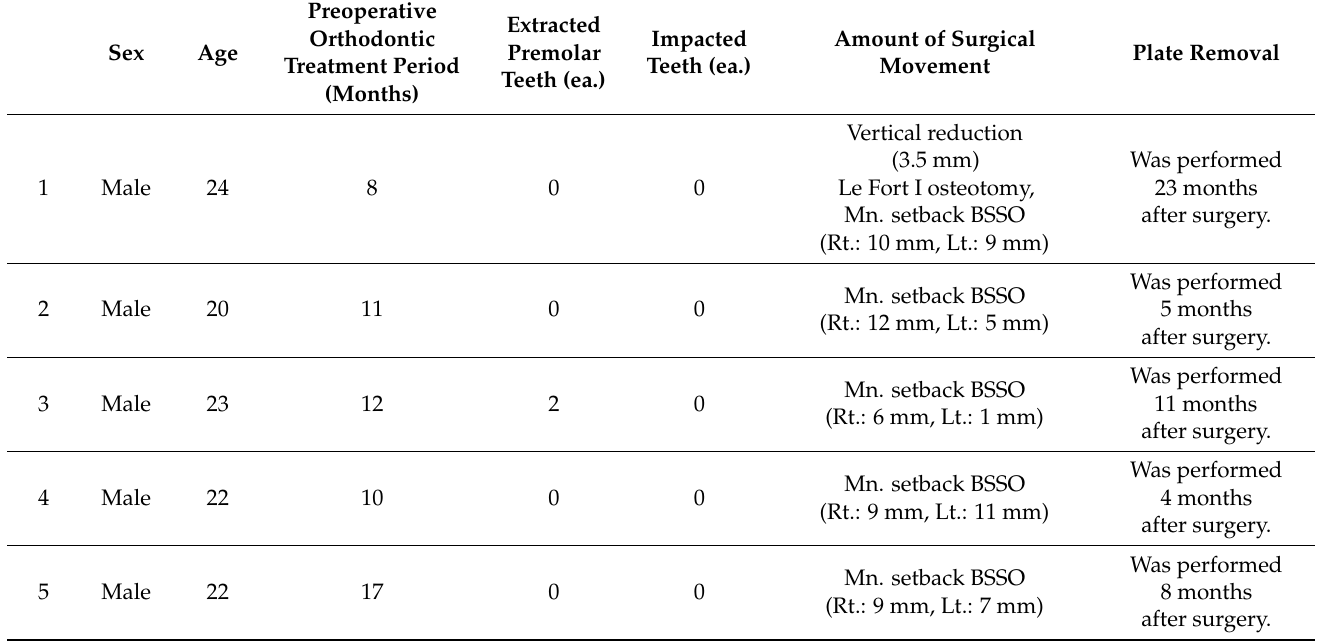
Table 4. Information on five patients with clear